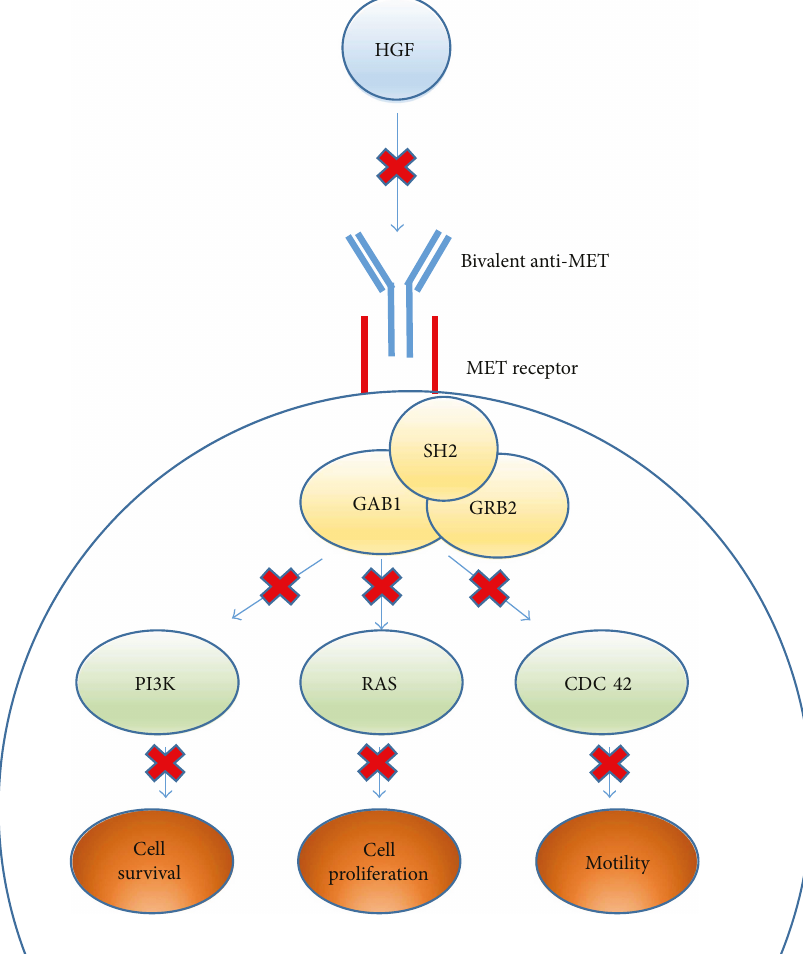
Figure 5: Bivalent design and function of anti-MET antibodies and siRNA aptamers. A bivalent anti-MET antibody blocks the HGF ligand from binding to the dimerized MET receptor. This prevents the activation of a multitude of factors required for tumor cell survival, proliferation, and